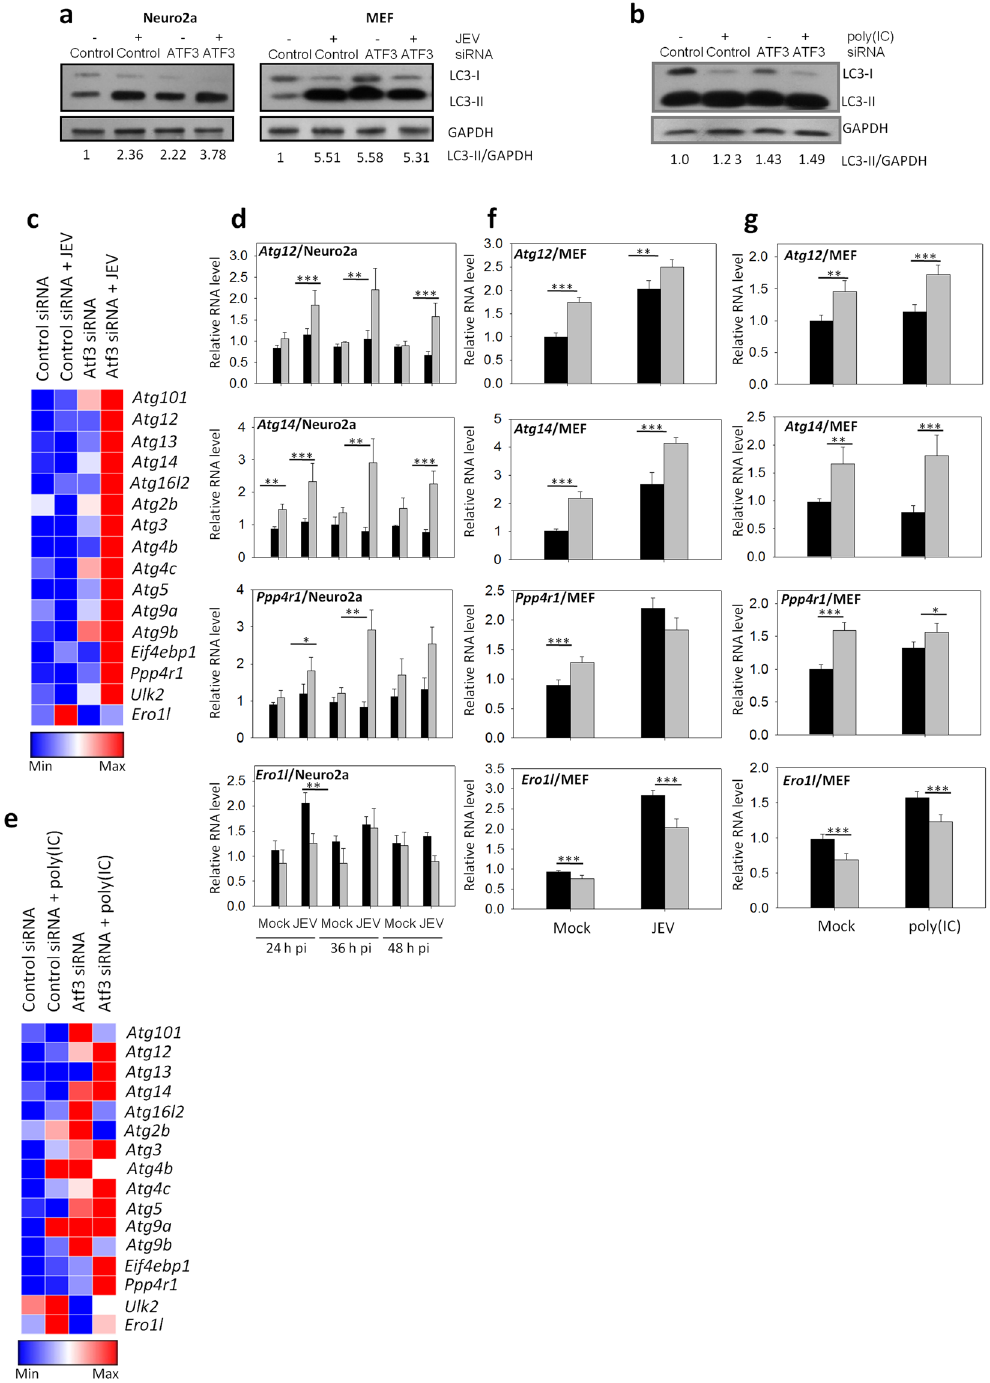
Figure 5. ATF3 negatively regulates cellular autophagy. ( a ) Neuro2a or MEF cells were treated with either a control or Atf3 -specific siRNA for 48 h and then infected with JEV (MOI 5). Total proteins were harvested at 24 h pi as cell lysates. Western blotting of LC3 was performed to study the induction of cellular autophagy. Shown below is the ratio of LC3-II/GAPDH. ( b ) Neuro2a cells were treated with either a control or Atf3 -specific siRNA for 48 h and then infected with JEV (MOI 5). Total RNA was isolated from the cells at 24 h pi and qRT PCR performed to determine the relative transcript levels for various autophagy-regulated genes. Mean values were used to create the heat map demonstrating the gene-expression profiles using the Gene-E software. ( d ) Neuro2a cells were treated with either a control or Atf3 -specific siRNA for 48 h and then infected with JEV (MOI 5). Relative expression of various genes at different times pi was studied by qRT PCR, and the mean value is plotted. ( e ) MEF cells were treated with either a control or Atf3 -specific siRNA for 48 h and then transfected with 1 μ g/ml poly(IC). Total RNA was isolated from the cells at 24 h post-transfection, and qRT PCR performed to determine the relative transcript levels of various autophagy-regulated genes, and the mean values were